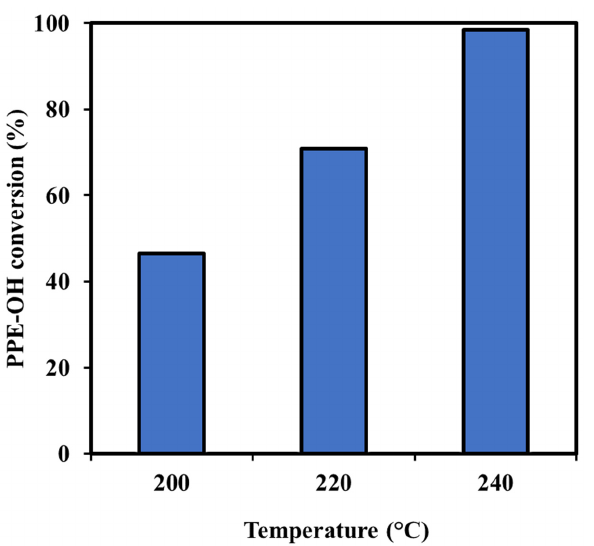
Figure 4. The conversion of 2-phenoxy-1-phenyl ethanol over Ru/C-KOH-2 catalyst at different temperatures. Reaction conditions: 1 h, N 2 atmosphere, 1 wt.% reactant/ethanol, 20 wt.% catalyst loading.